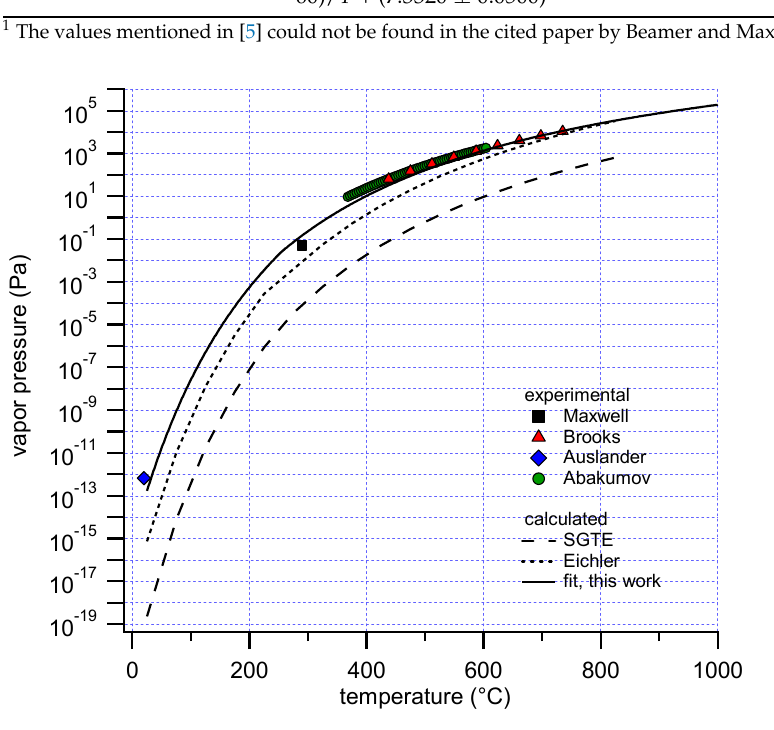
Figure 1. Vapor pressure of polonium metal. (markers) experimental data, (curves) calculation re- sults.